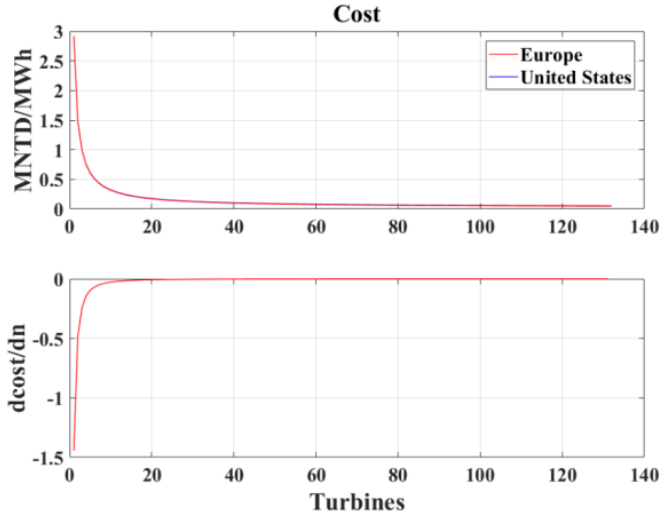
Figure 11. Cost of energy with different numbers of turbines and the cost of including an additional turbine. The lines of Europe and United States overlap, indicating that the energy cost and the cost of including an additional turbine are similar when calculated using Europe’s and United States’ expenditures. (dcost: additional cost, dn: additional turbine).